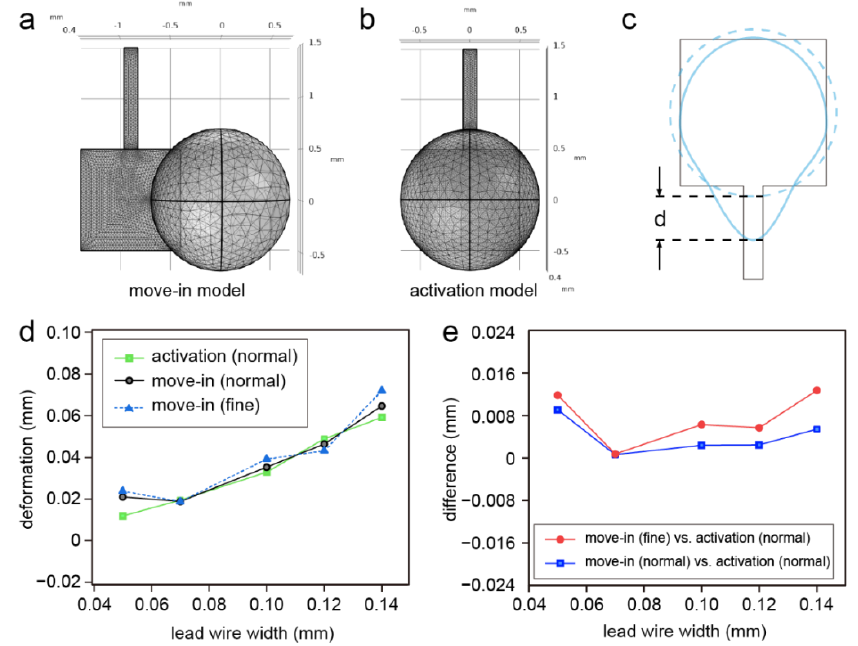
Figure 3. ( a ) The mesh of the move-in model with a normal element size; ( b ) the mesh of the activation model with a normal element size; ( c ) the definition of the droplet deformation; ( d ) simulation results of the droplet deformation based on the two models: the move-in model with a normal element size (black line) and a fine element size (dashed blue line) and the activation model with a normal element size (green line); ( e ) the difference in droplet deformations in comparison with the simulated activation model.